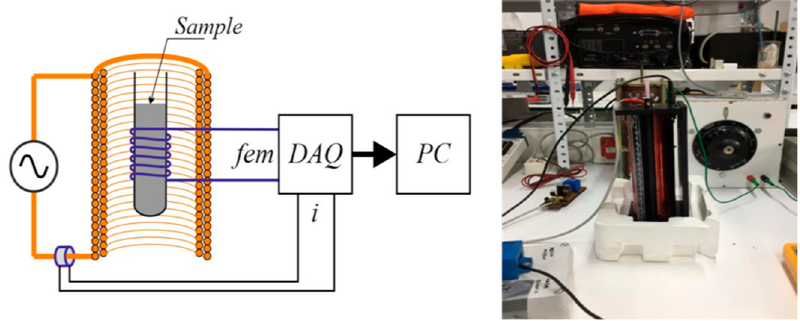
Figure 7. Self-made experimental installation for the measurement of magnetic properties.